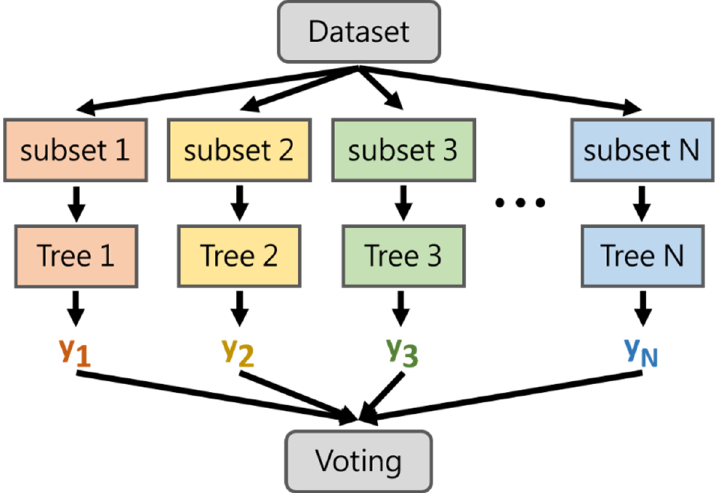
Figure 3. The flowchart of the random forest algorithm.